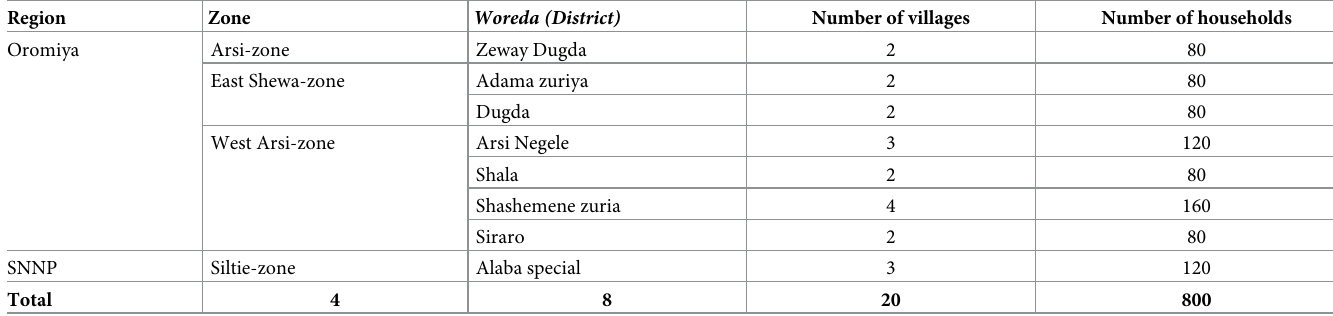
Table 1. Sampled districts, villages and